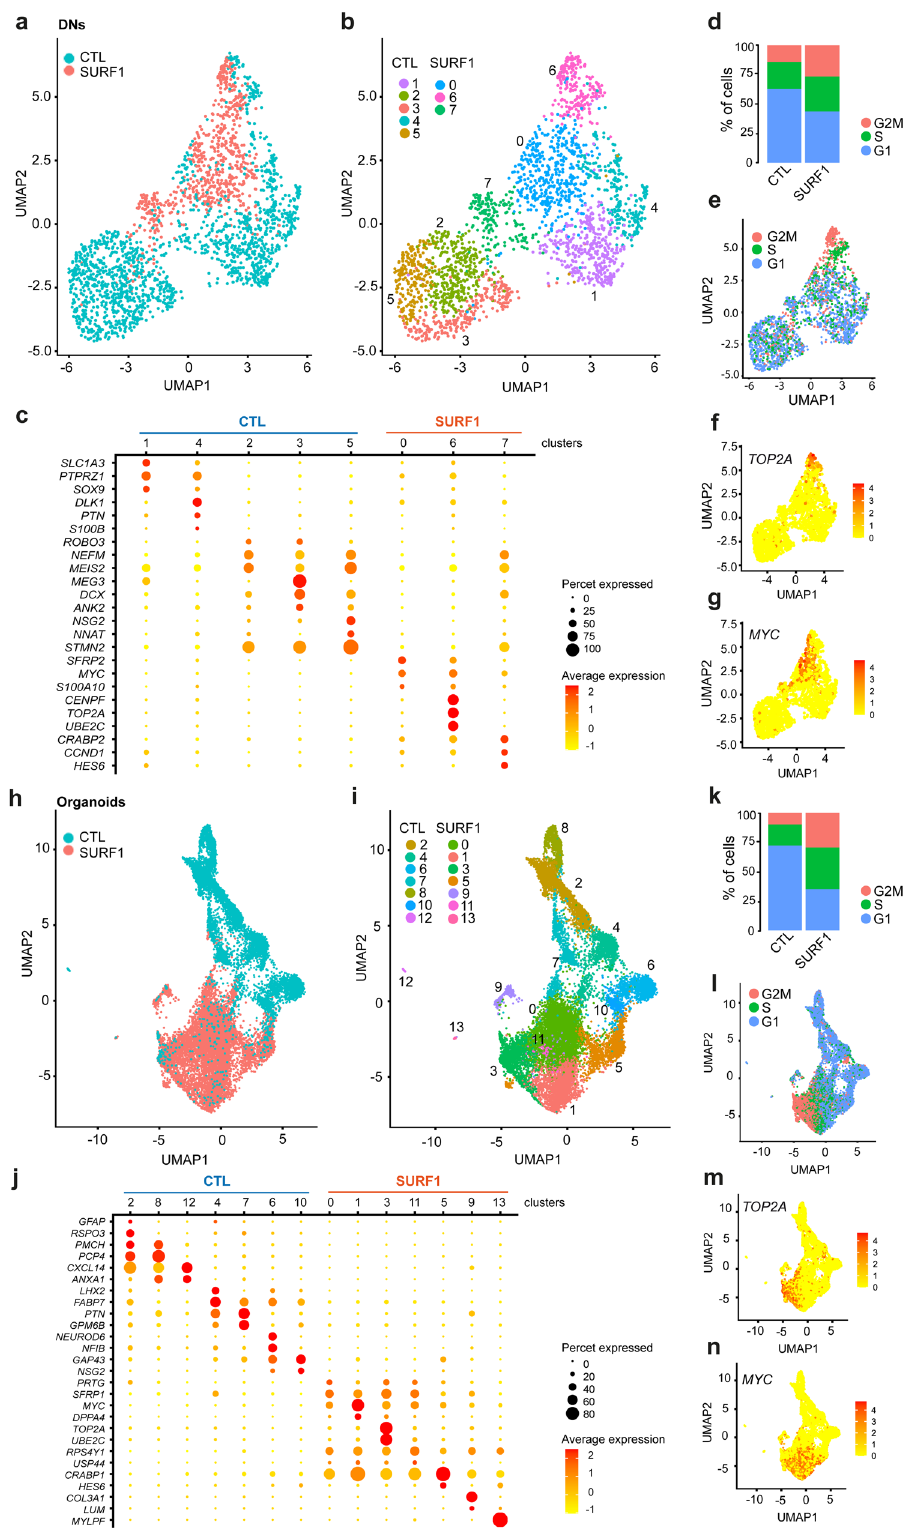
SURF1 organoids populated clusters 0, 1, 3, 5, 9, 11, and 13 (Fig. 3i, j). Cluster 0, 1, 3, and 11 contained cells expressing proliferative and cell cycle genes ( CRABP1, SFRP1, MYC, TOP2A, UBE2C, PRTG) , and pluripotency-associated genes ( LIN28A, DPPA4, POU5F1 , USP44 ) (Fig. 3j, Supplementary Data 3). Cells in cluster 5 resembled those in cluster 7 of DNs, and included